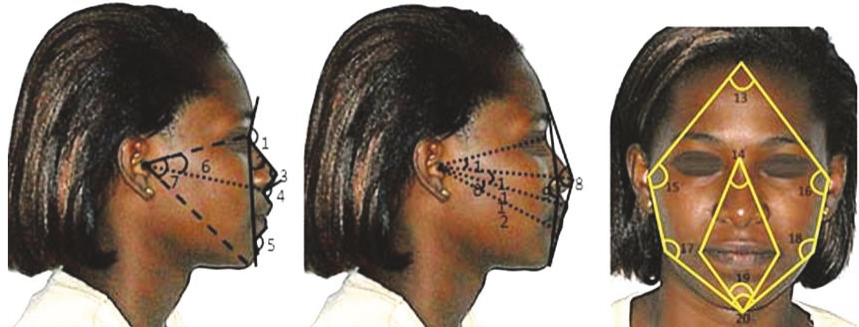
Figure 3: Internal and external angles of the face (full face and the profile). (1) Nasofrontal angle (G-N-Prn): the angle between the tangent lines on the nasal bridge and the glabella. (2) Nasomental angle: formed by the intersection of a line drawn between the nasion point (N), the pronasale point, and another line running from the point nasion (N) to the pogonion point (Pog). (3) Pronasale angle (N-Prn-Sn): formed by the nasion, pronasale, and subnasale points. (4) Nasolabial angle (C-Sn-Ls): it is the angle between the points columella, subnasale, and labiale superius. (5) Mentolabial angle (Li-Sm-Pog): angle formed by the lower lip, the supramental and pogonion points. (6) Angle of the middle-third of the face (N-Po-Sn): angle formed by the nasion (Sn), porion (Po), and subnasale points. (7) Angle of the lower third of the face (Sn-Po-Me): formed by the glabella (G), pronasale (Prn), and pogonion (Pog) points. (8) Facial angle (G-Prn-Pog): formed by the glabella (G), pronasale (Prn), and pogonion (Pog) points. (9) Angle of the facial convexity excluding the nose (G-Sn-Pog): formed by the intersection of the horizontal plane of Frankfort (Po-Or), a line tangential to the chin skin (Me) and to the foremost lip (L). (10) N-Po-Prn angle: formed with the nasion (Na), porion (Po), and pronasale (Prn) points. (11) Prn-Po-Ls angle: formed with the pronasale (Prn), porion (Po), and labiale superius (Ls). (12) Interlabial angle (Sn-Ls/Li-Sm): formed with the intersection of a line drawn between the subnasale point and the labiale superius and another line drawn from the lower furrow and tangent to the lower lip. (13) Zy.r-Tr-Zy.l: angle of the face width: formed by the trichion points at the two bilateral zygion points. (14) Ch.r-N-Ch.l angle: it is the nasion angle formed by the nasion point bound to the two bilateral labial commissure points. (15), (16) Left and right Tr-Zy-Go angles: left and right zygomatic angles (formed by the left and right zygion point, bound to the trichion and gonion points). (17), (18) left and right Zy-Go-Gn angles: left and right gonion angles: formed by the left and right gonion point, bound to the zygion and gnathion points at each side. (19) Angle of the oral width (Ch.r-Gn-Ch.l): formed by the gnathion point bound to the two bilateral labial commissure points. (20) Angle of the mandibular width (Go.r-Gn-Go.l) formed by the gnathion point linked to the two bilateral gonion points. r: right; l: left . r 2 = 0,3774;r = −0,6143;p = 0,0000010; y = 225,5663 − 133,6348∗x